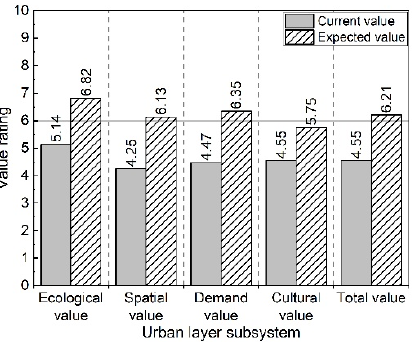
Figure 6. The average current and expected value of Beijing’s waterfront.